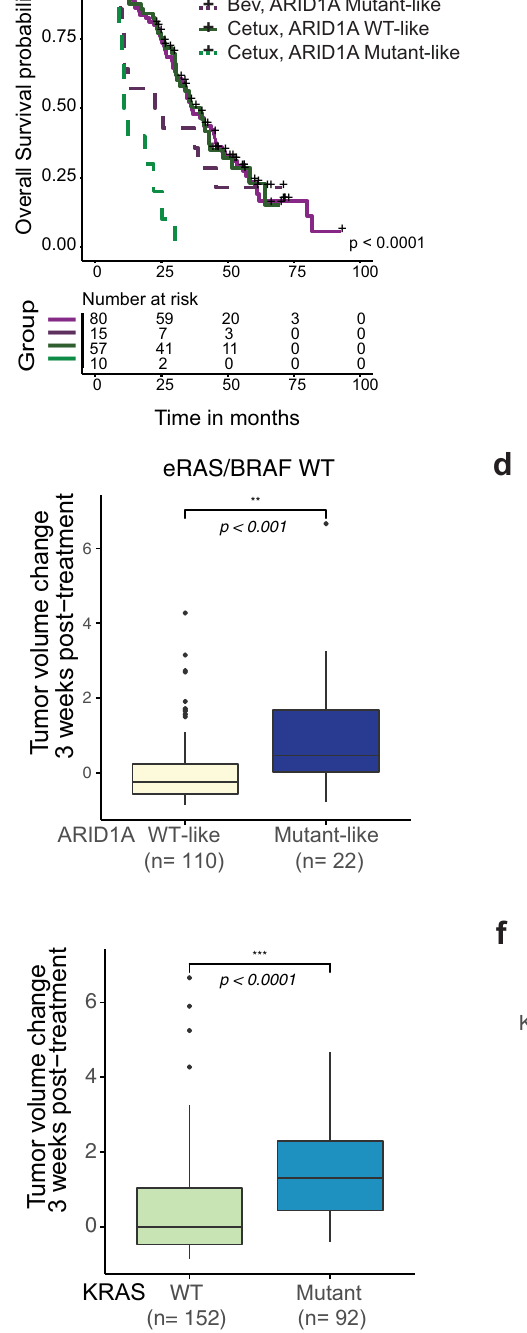
data are providedasa Source Data fi le. c , e Changeintumor volumefrom baseline to after 3 weeks on cetuximab treatment (20mg/kg, twice a week) for 132 eRAS/ BRAF WT PDX models shown by ARID1A signature group ( c ), and for all 244 PDX models shown by KRAS mutation status ( e ). p -values by two-sided Wilcoxon rank sumtest(*** p